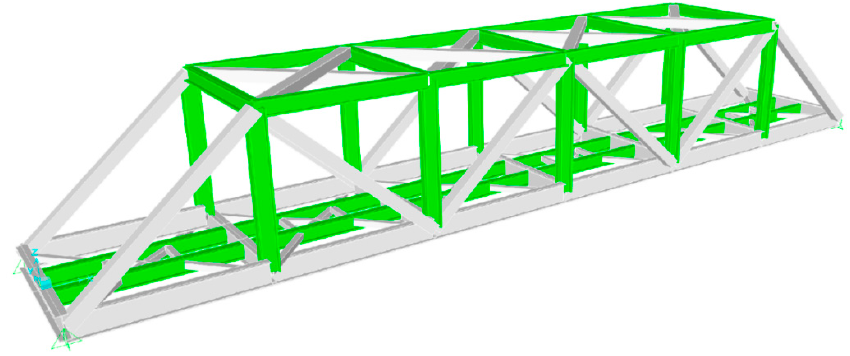
Figure 2. Finite element model of the truss bridge.